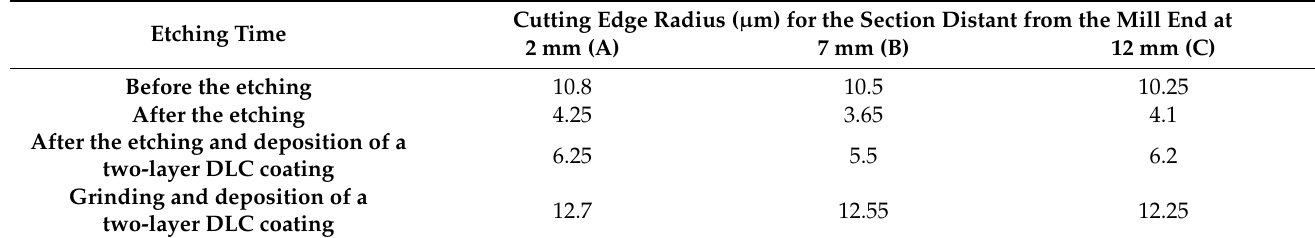
Figure 12. Profiles of cutting edge radii after etching and deposition of a two-layer DLC coating in four sections distanced from the mill end at 12 mm and distanced from each other at 0.05 mm. Table 3. Cutting edge radii end mills.